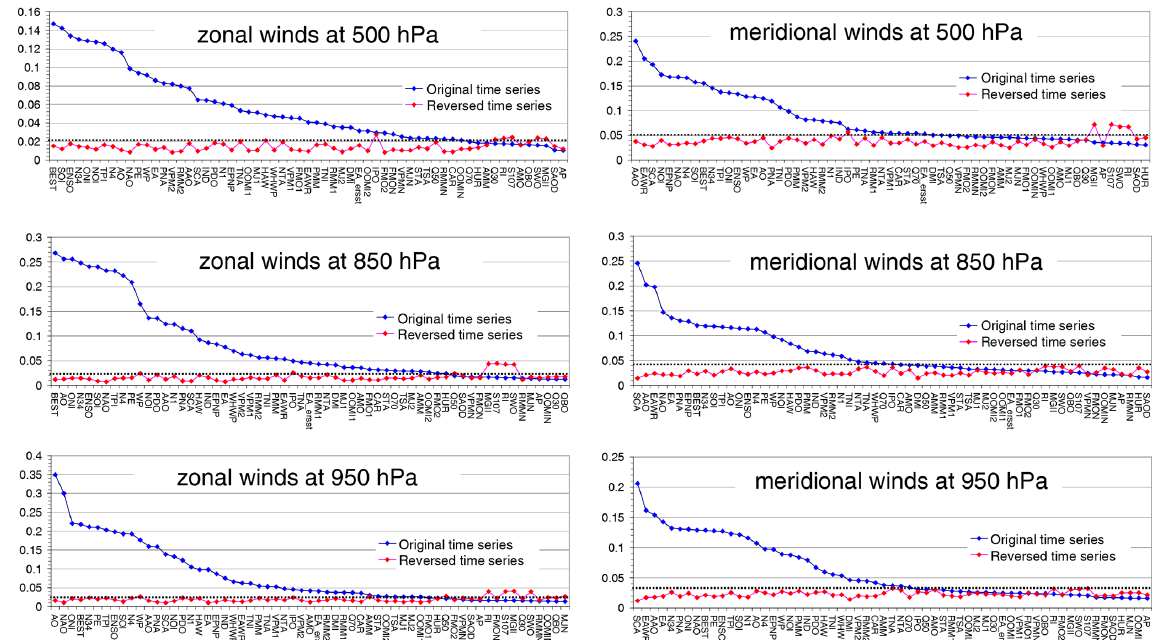
Figure A10. The 99th percentiles of the delta rms values (p99) found for the different indices in different global data sets. Blue markers: p99 for the original indices; red markers: p99 for the temporally reversed indices; black lines: significance thresholds. The indices are sorted from highest to lowest p99 values for the original indices.